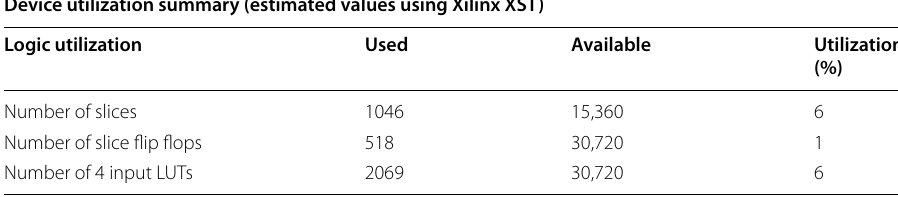
Table 2 Salsa 20/20—device